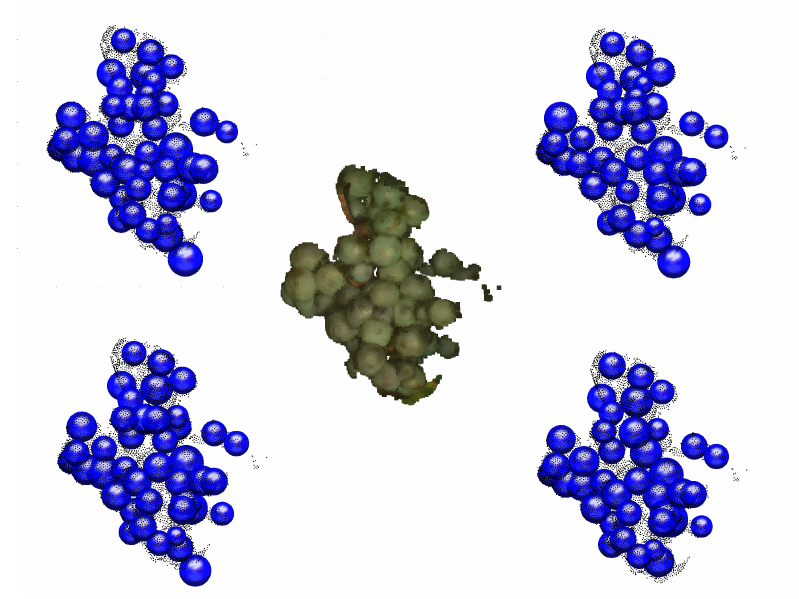
Figure 15. The original grape bunch point cloud is seen in the middle. In the corners, exemplary results of four runs of findBerries are